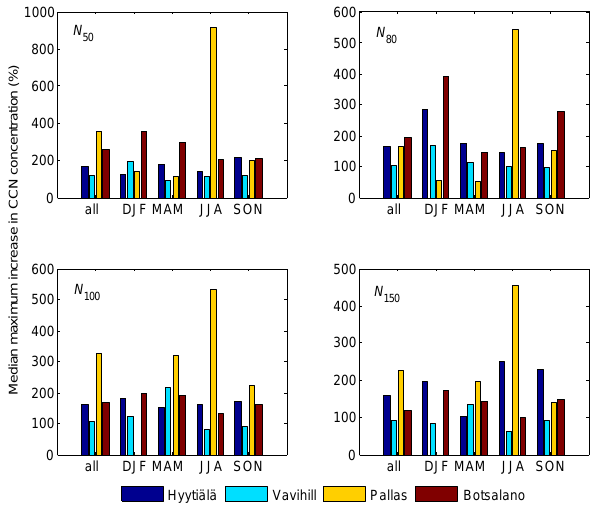
Fig. 6. Median maximum increase in four examined CCN concen- trations expressed in particles per cm 3 as a result of nucleation at four locations. The results are shown separately for all events and for different